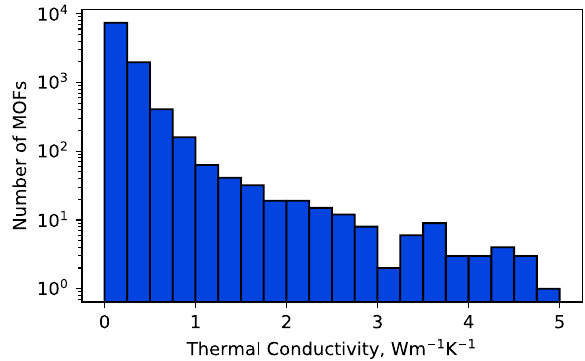
Fig. 2 The distribution of thermal conductivity data. The distribution of the The vertical axis is logarithmic.